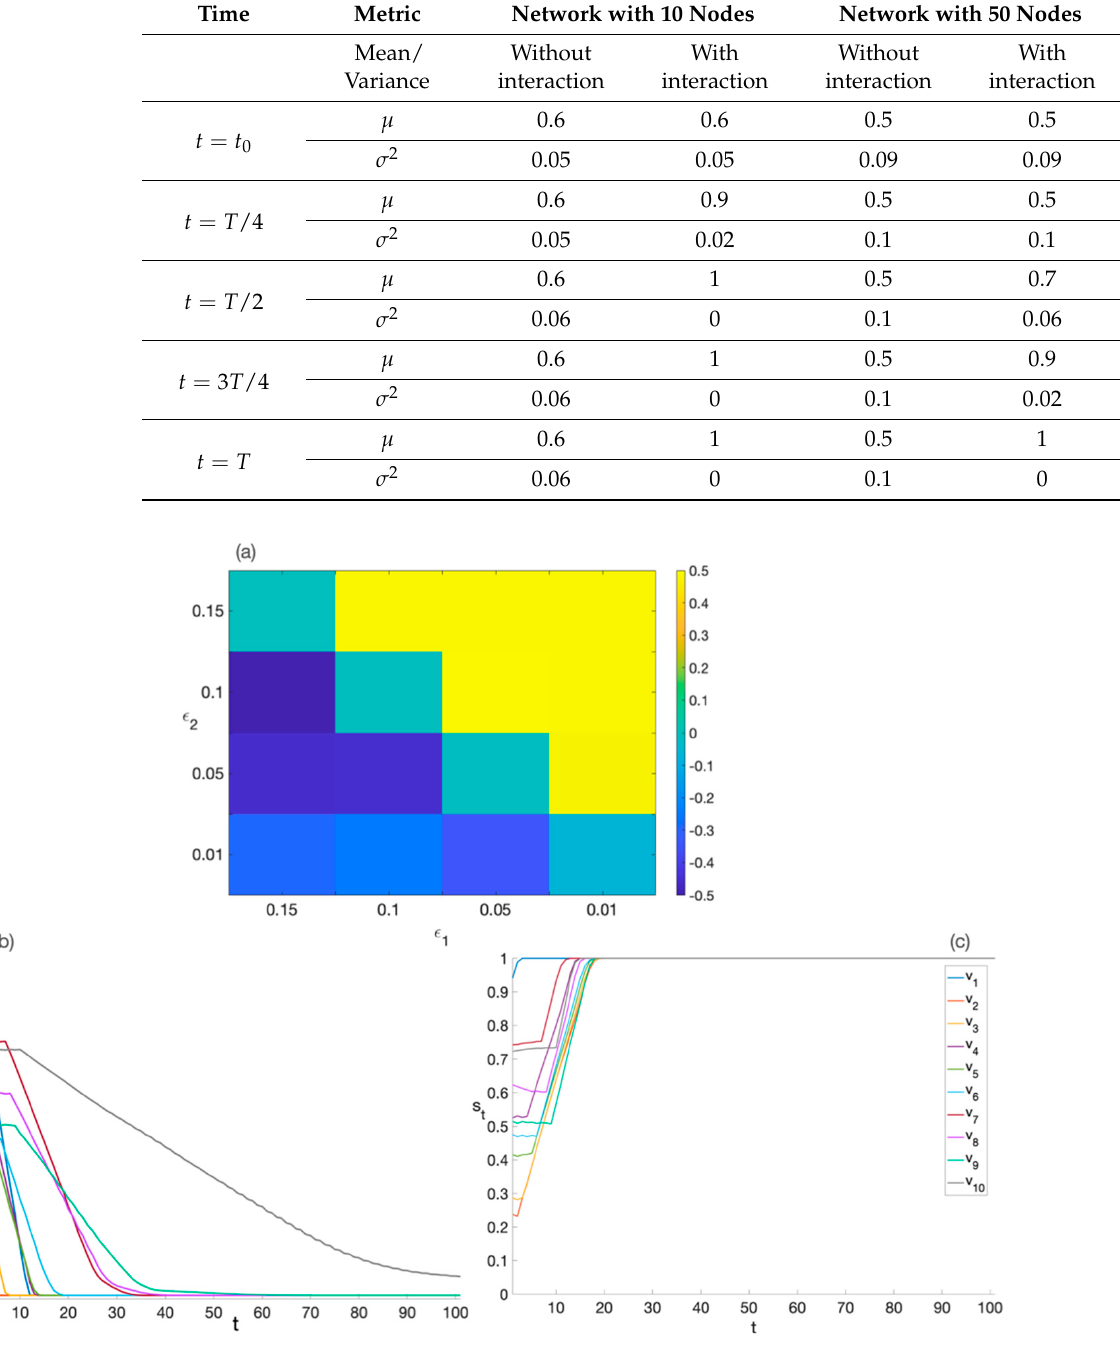
Figure 4. Comparison of pairs of state evolutions, with and without interactions, for different combinations of the parameters 𝜀 (cid:2869) and 𝜀 (cid:2870) (panel a). The color indicates the gain obtained considering each specific pair. It is computed as n (cid:3036)(cid:2880)(cid:2869) ∑ ( (cid:82) s i − z i (cid:3041) dt ) , where s i and z i are the state evolutions with and without interaction, respectively, and n is the number of nodes. State evolutions for harmful (panel b, 𝜀 (cid:2869) = 0.01, 𝜀 (cid:2870) = 0.1) and helpful (panel c, 𝜀 (cid:2869) = 0.1, 𝜀 (cid:2870) = 0.01) interactions, respectively. All the other parameters are 𝛼 = 1, 𝛽 = 1.5, 𝛾 = [5, 1, 0.01], and 𝛿 = 0.75 .